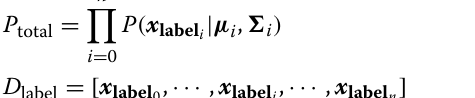
Validation of DNN